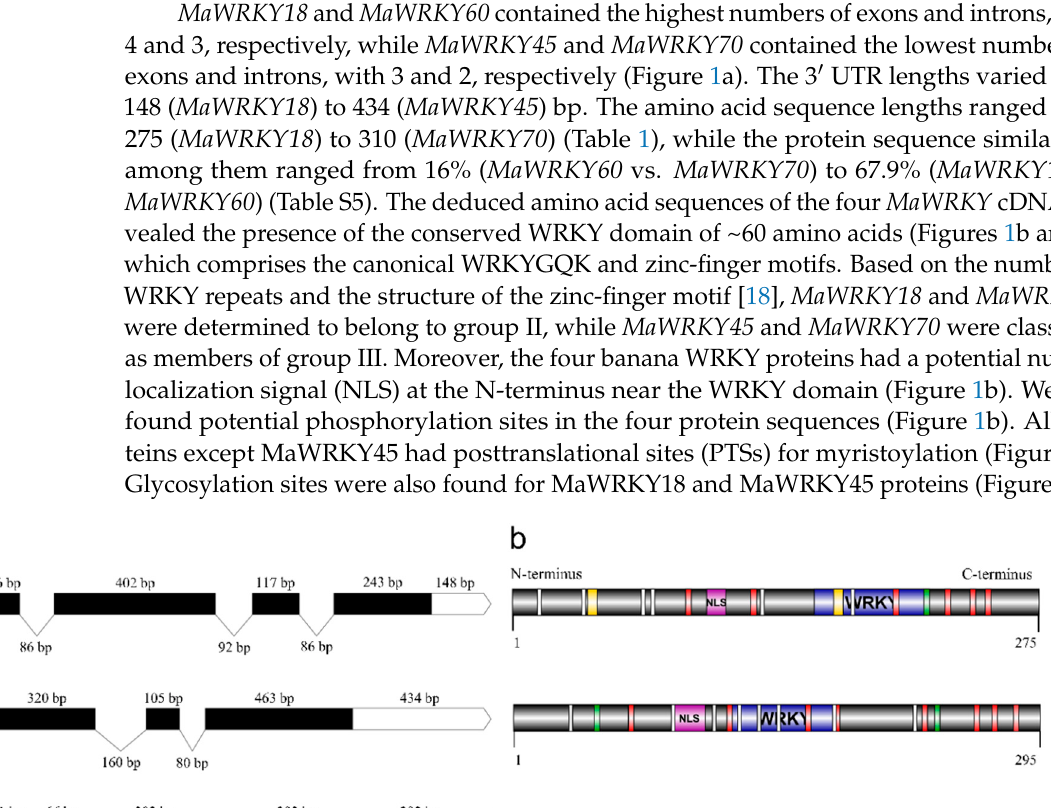
Figure 2. Multiple sequence alignment of the proteins MaWRKY18, MaWRKY45, MaWRKY60, MaWRKY70, and their homologs from rice and Arabidopsis . Identical and similar amino acids are shaded in black and gray, respectively. The amino acids of the WRKYGQK and zinc-finger motifs are highlighted with asterisks and black circles, respectively. The 3D models of MaWRKY18, MaWRKY45, MaWRKY60, and MaWRKY70 (Figure 3) showed four antiparallel β -sheets comprising the WRKY DNA-binding domain similar to the WRKY domain of the Arabidopsis AtWRKY1 protein [44]. The phylogenetic tree (Fig-